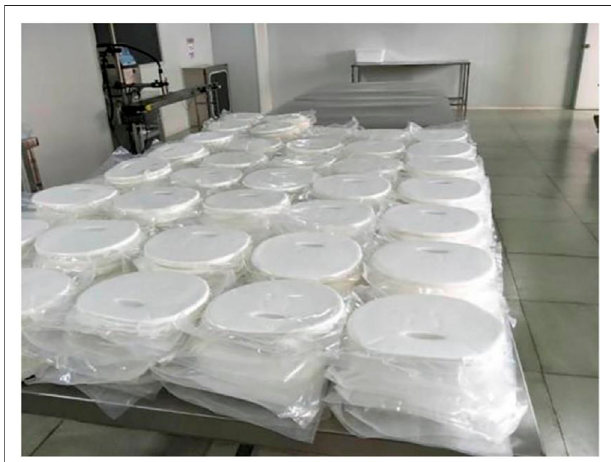
FIGURE7| FacemasksmadefromBNC-basedrawmaterial.Reprinted with permission from Zhong (2020) under Creative Commons Attribution License (CC